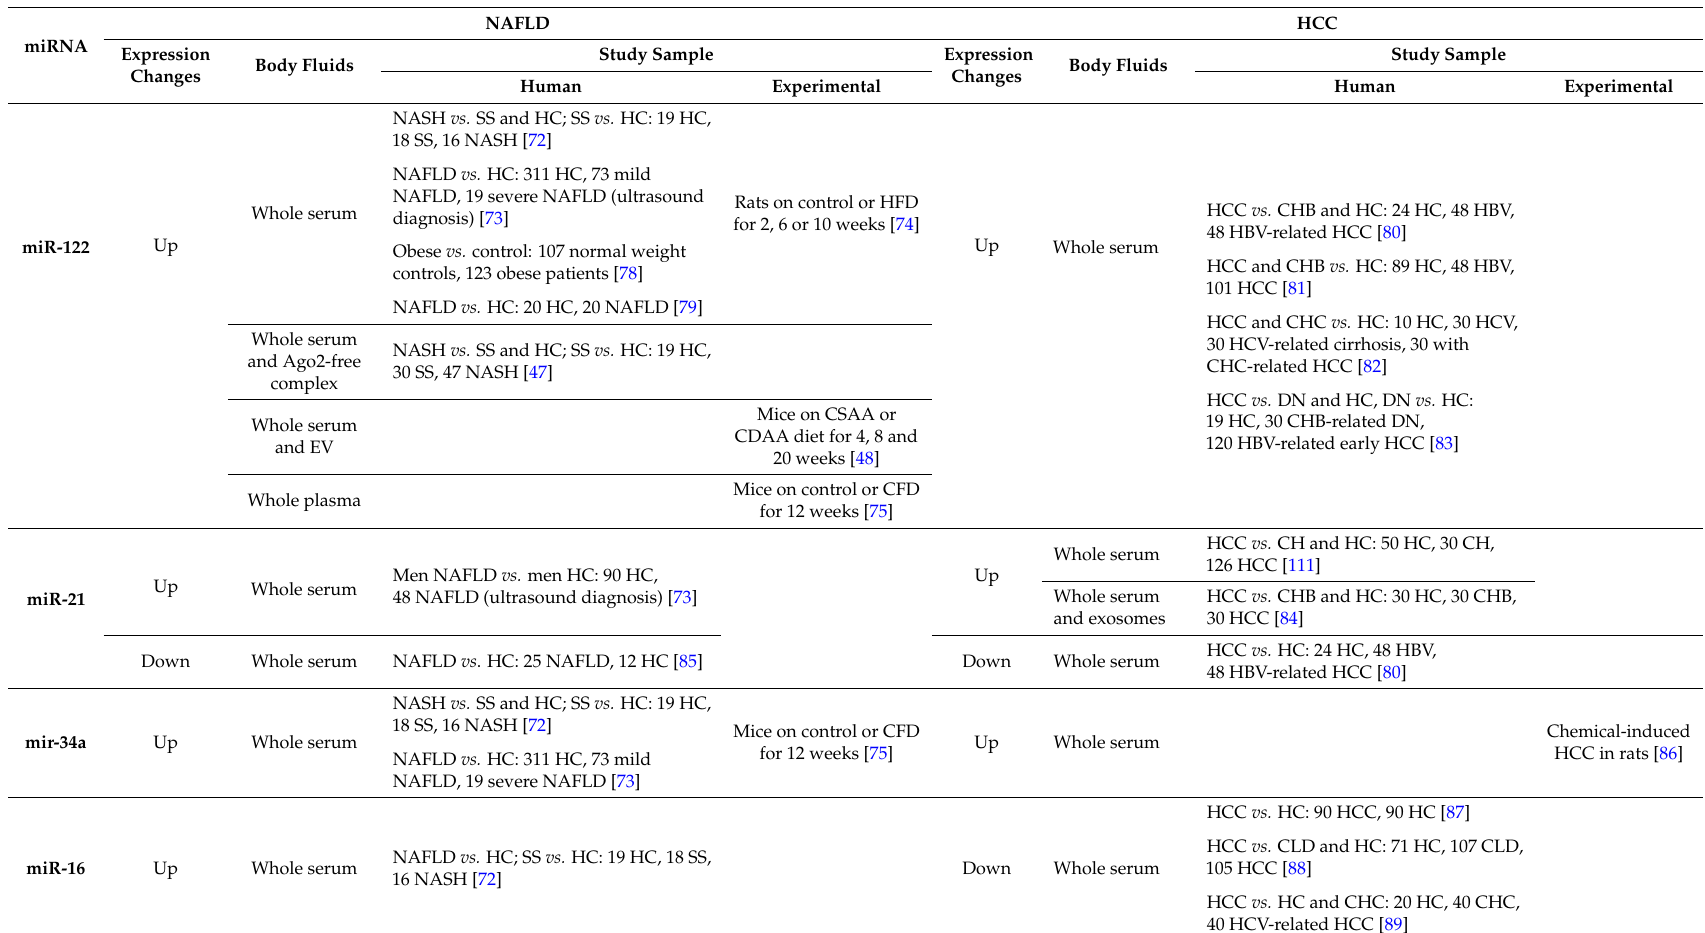
Table 1. Summary of circulating miRNAs aberrantly expressed in both NAFLD and